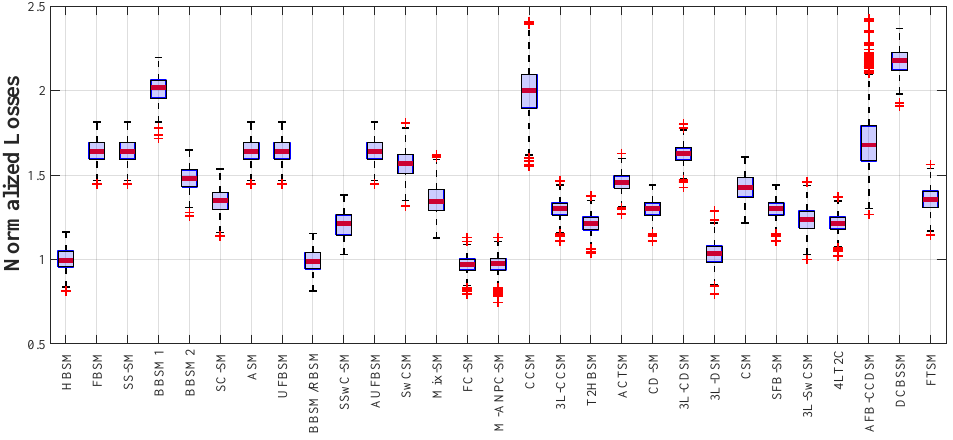
Figure 21. Losses of SMs over 1000 consecutive periods at unity power factor